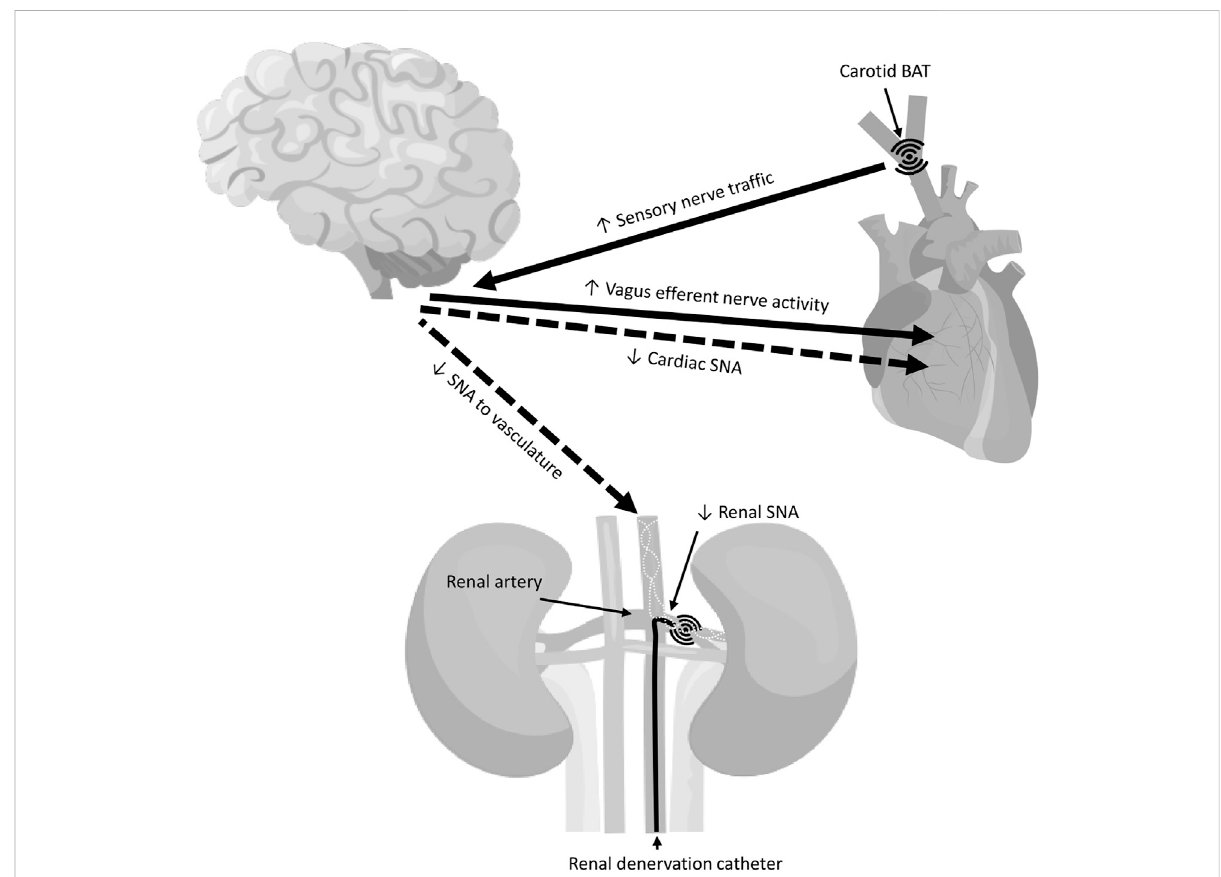
FIGURE 2 Surgical interventions to lowerbloodpressure(BP)inresistanthypertensivepatientsincludingbarore fl exactivation therapy(BAT)ofthecarotid baroreceptors and renal denervation using radiofrequency/ultrasound energy ablation of the renal nerves. Note that BAT evokes fi eld stimulation of thebaroreceptorswithinthecarotidsinus,whichincreasessensoryafferenttraf fi ccarriedbythecarotidsinusnervestothebrain.Thisresultsinre fl ex increases in vagal efferent out fl ow to the heart and decreases in sympathetic discharge to the heart and vasculature thereby reducing cardiac outputandsystemicvascularresistance,andultimatelyBP.Inrenaldenervation,on theotherhand,theprocedureeliminatesbothrenal afferentand efferent activity including renal sympathetic nerve activity (SNA), the excessive activation of which is thought to be the driver of increased BP in hypertensive individuals. Adapted and modi fi ed from (Bhatt et al., 2019; Gajulapalli et al.,